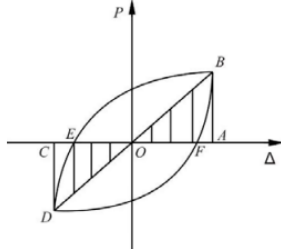
Figure 25. Calculation diagram of h e .